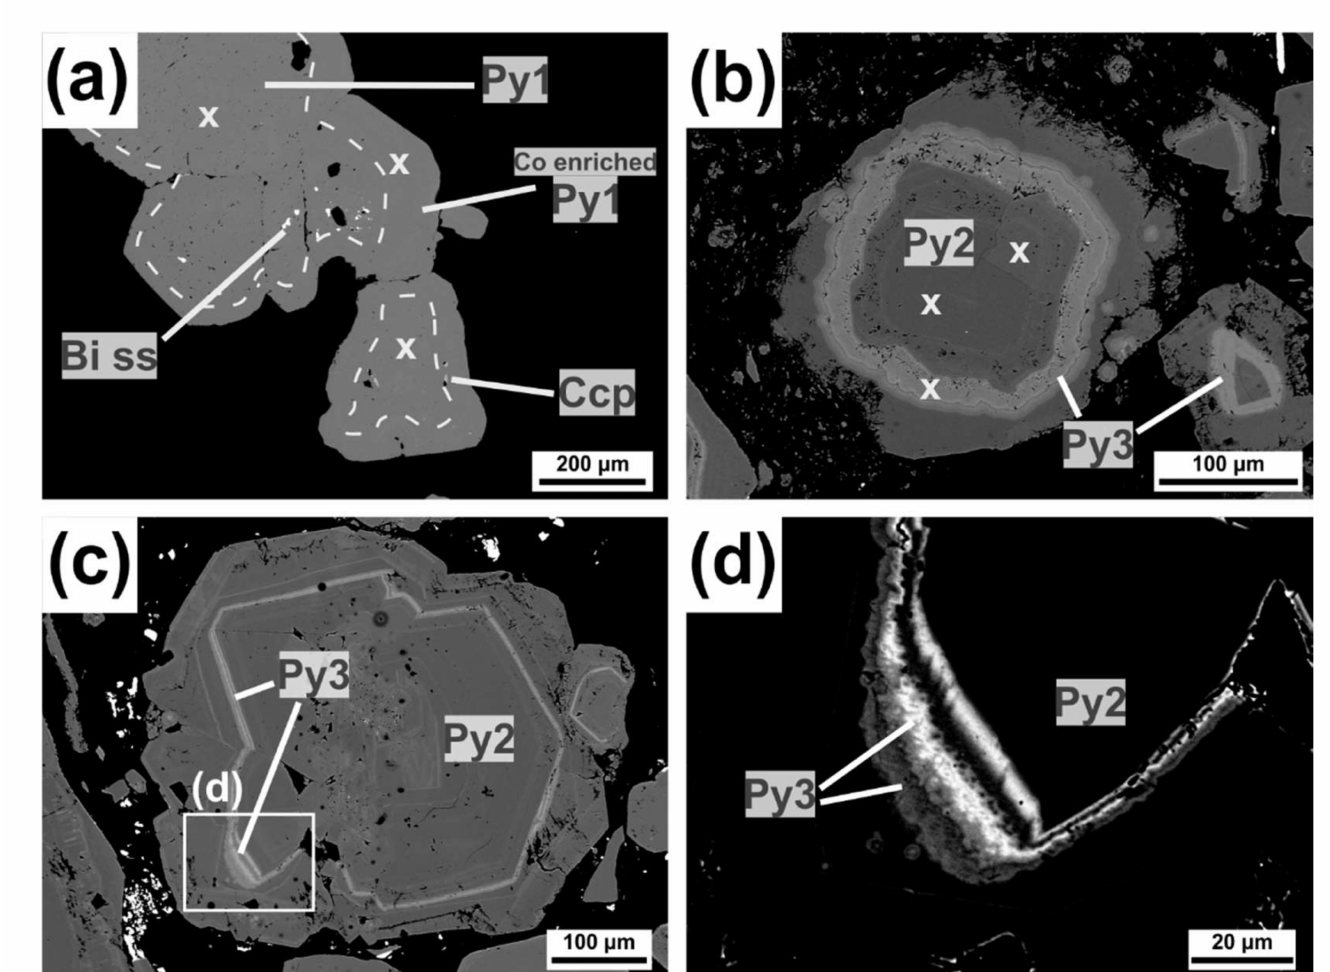
Figure 9. Back-scattered electron (BSE) images showing different types of pyrite from the Kizhnica quarry: ( a ) pyrite 1 (Py1) containing inclusions of bismuth sulfosalts and chalcopyrite, outer rim enriched in Co; ( b ) pyrite 2 (Py2) with a zone of arsenian pyrite 3 (Py3); ( c ) pyrite 2 (Py2) with arsenian pyrite 3 (Py3) zones; ( d ) detail of image ( c ) irregular zones of arsenian pyrite (Py3) in pyrite 2 (Py2). Abbreviations: Bi ss = bismuth sulfosalts; Ccp = chalcopyrite; Py = pyrite; x = LA-ICP-MS